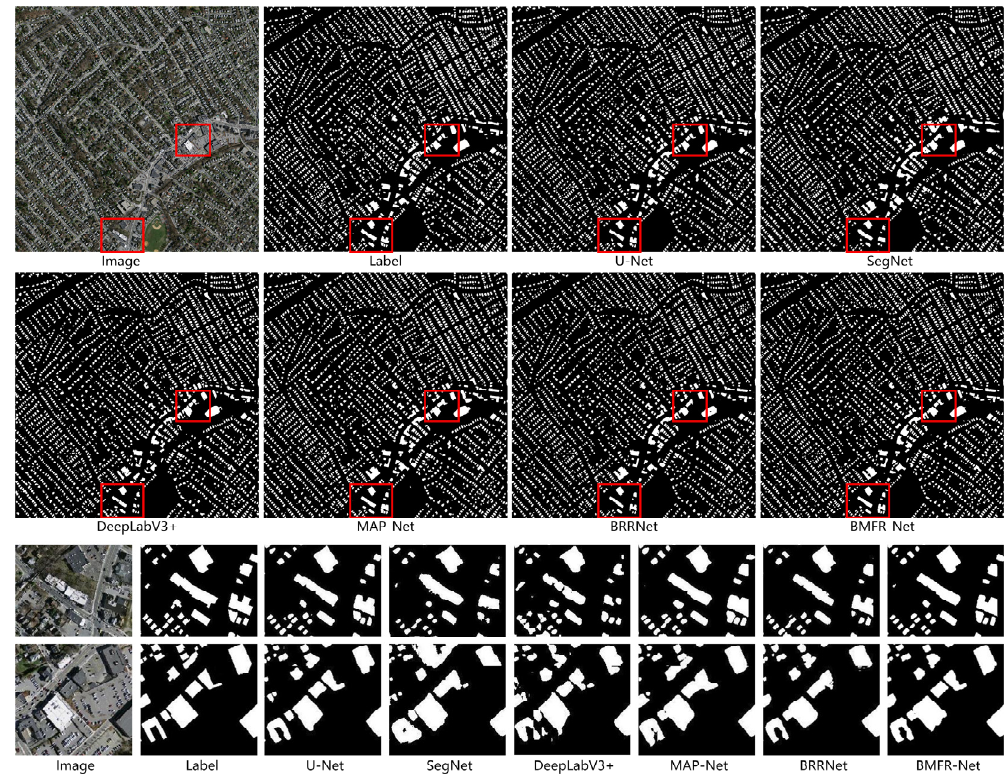
Figure 12. Extensive area building extraction results by different methods on the Massachusetts Building Dataset. The bottom column represents the corresponding partial details.